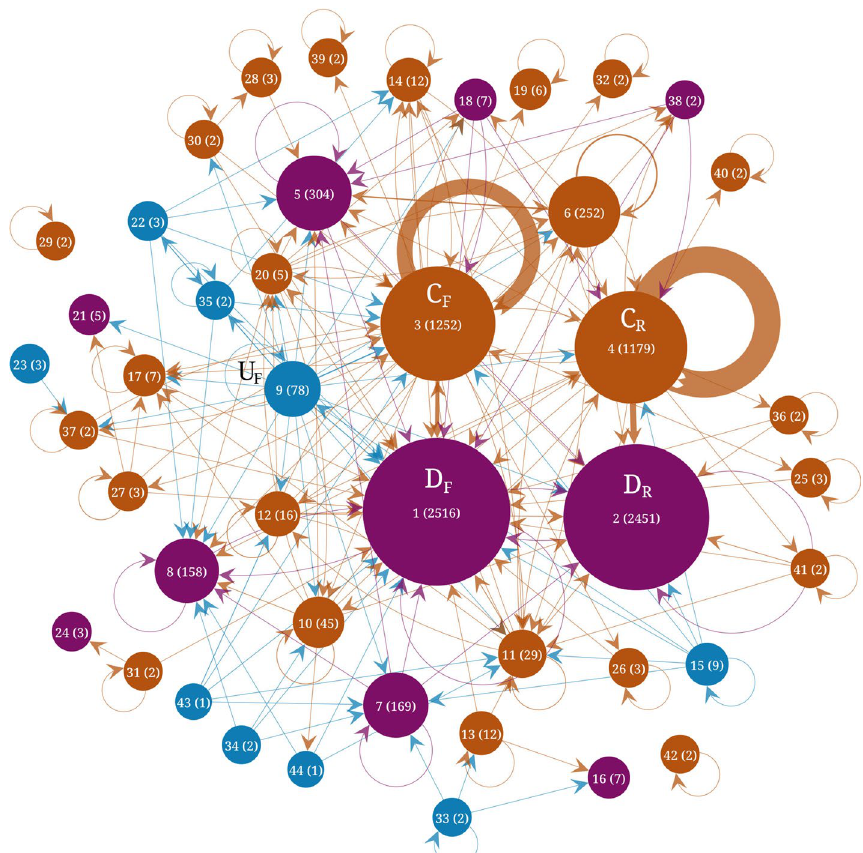
Fig. 6 Flow stability clustering of the telegram channels network G 3 (March 2020 to Dec. 2020). Nodes represent the communities and edges represents the number of links between channels in each community. Upstream communities are shown in blue, core communities in brown and downstream communities in purple. The labels indicate the rank of each community in terms of size and the size is indicated in